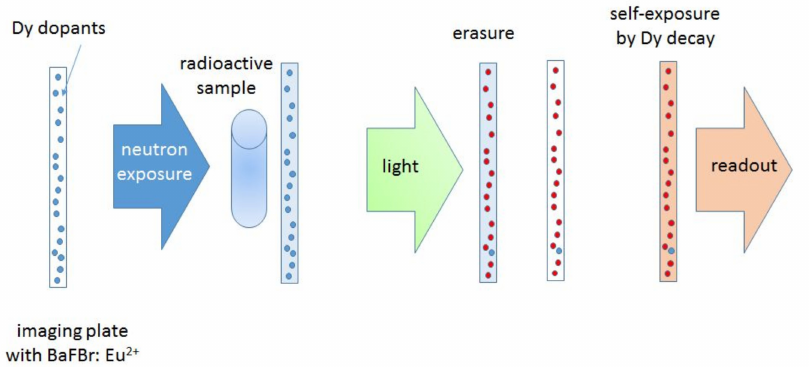
Figure 3. Principal steps employing activation of Dy by neutrons: the imaging plate (IP) with the Dy exposed with the radioactive sample in front (overexposure by gamma radiation allowed); all signal is removed by bright-light erasure; the decay activity from Dy-165m return the “copy” of the neutron radiography